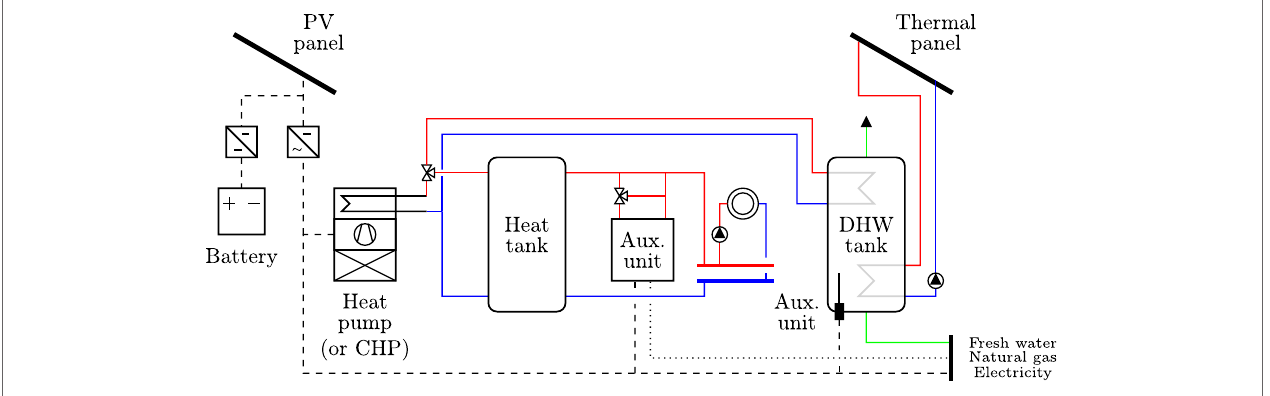
FIGURE 6 | Energy system pseudo-superstructure (Stadler et al.,